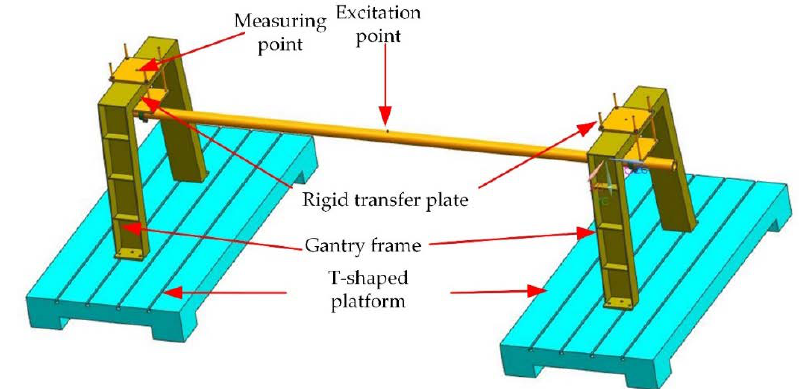
Figure 9. Arrangement of measuring points and excitation point.